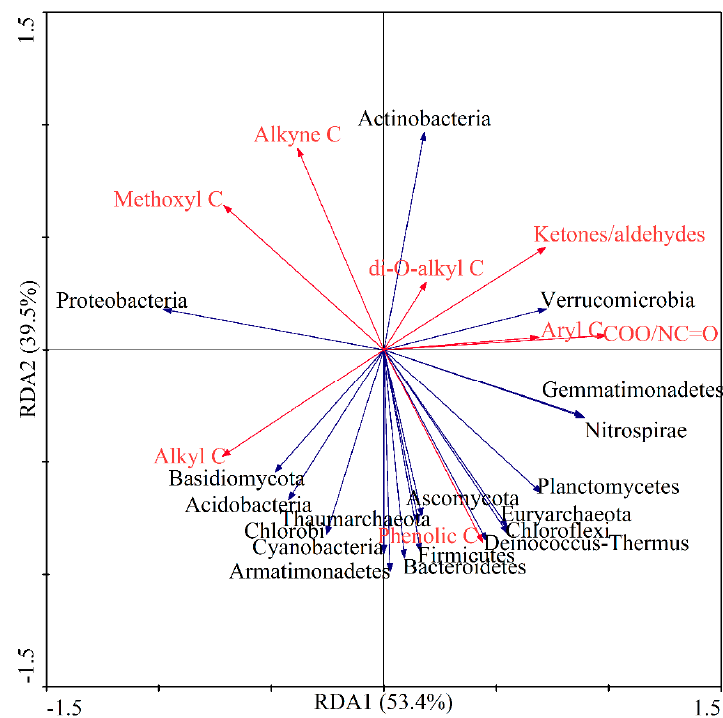
Figure 12. Redundancy analysis (RDA) illustrating the effects of SOC chemical functional groups on soil microbial community composition.